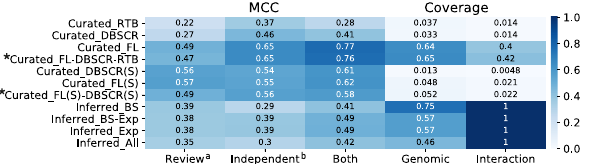
Figure 6. MCC for global regulators predicted by NDA for each of the curated and inferred networks. Scores ≥ 0.5 are represented in white numbers and meta-curations are marked with an asterisk. a Gold standard curated from reference 28 . b Gold standard curated from independent publications (Supplementary Table